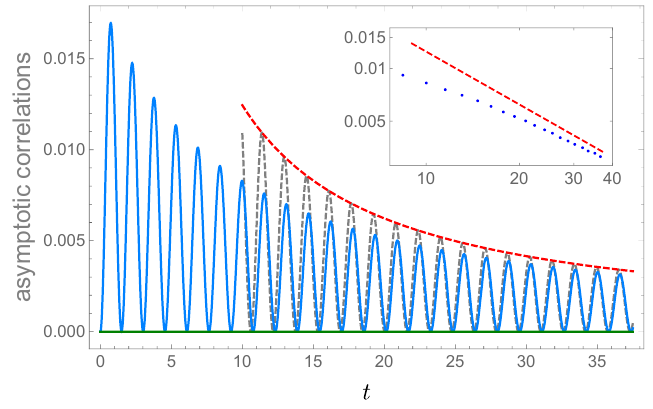
Figure 3 . Time evolution of the large distance asymptotics lim x !1 h (cid:5)(0 ; t )(cid:5)( x; t ) i (blue line) together with their large time scaling (cid:24) sin 2 (2 Mt ) =t and envelope (gray and red dashed lines respectively). The vanishing large distance asymptotics of @ x (cid:8) correlations (green line) are included for completeness. Inset : log-log plot showing the large time scaling of asymptotic (cid:5) correlations. The points are the maxima of the oscillations and the red dashed line the (cid:24) 1 =t envelope. The quench parameters are same as in (cid:12)gure